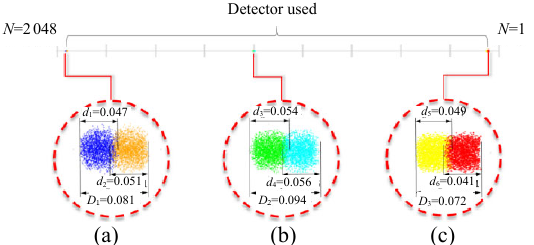
Fig. 4 Three sets of image spots in different wavelength ranges: (a) 1 525 nm (blue) and 1 525.06 nm (orange), (b) 1 545 nm (green) and 1 545.06 nm (sky blue), and (c) 1 565 nm (red) and 1 564.94 nm (yellow).